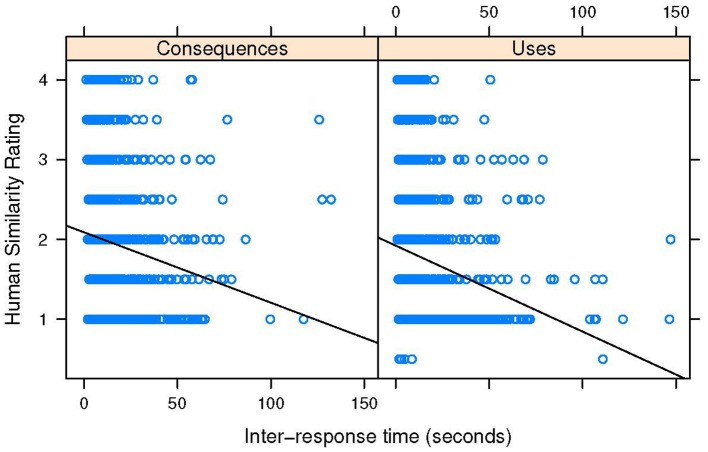
Scatter plots of inter-response time and pairwise similarity for the two prompt conditions. Solid line represents ordinary least squares regression. See Table 3 for the actual regression results from mixed-effects modeling.